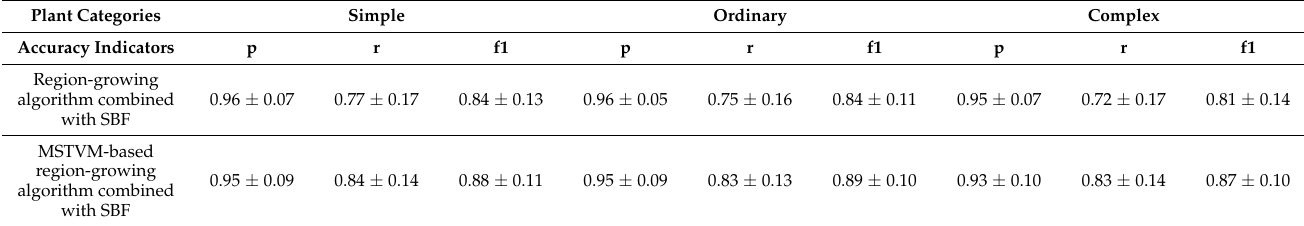
Table 6. The t-test of precision, recall, and F1-Score values of segmented leaves for the whole plant by the MSTVM-based region-growing algorithm combined with SBF and by the region-growing algorithm combined with SBF.